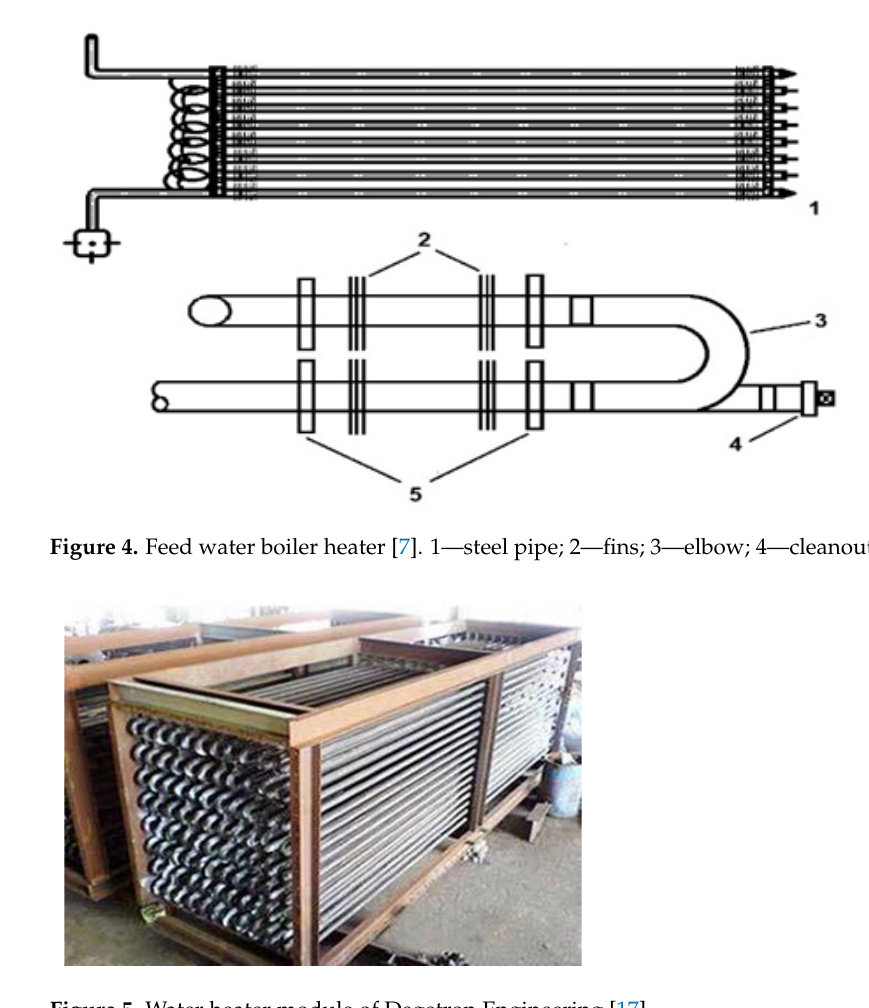
Figure 5. Water heater module of Degetron Engineering [17].